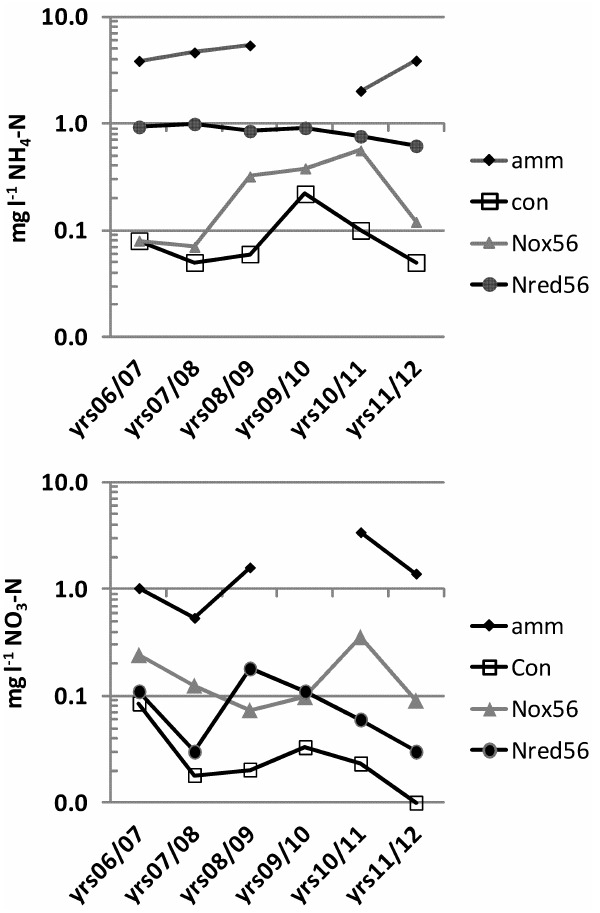
Fig. 3. Annual mean concentrations of nitrate and ammonium N ( + / − sterr) in soil pore water collected with suction samplers emp- tied monthly. Data from 2006 for the control (no added N) and N treated (oxidised (Nox), reduced (Nred) and ammonia (amm)) plots ( ∼ 56kgNha − 1 yr − 1 ) at Whim bog. No data were collected for the amm plots in years 2009/2010.